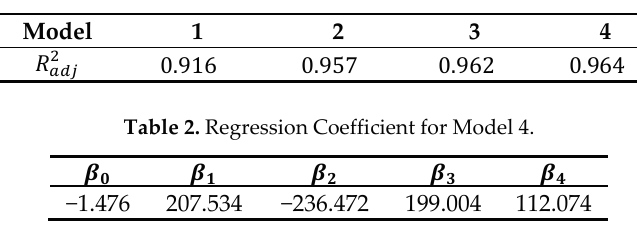
Table 1. Adjusted coefficients of determination of the four different models.